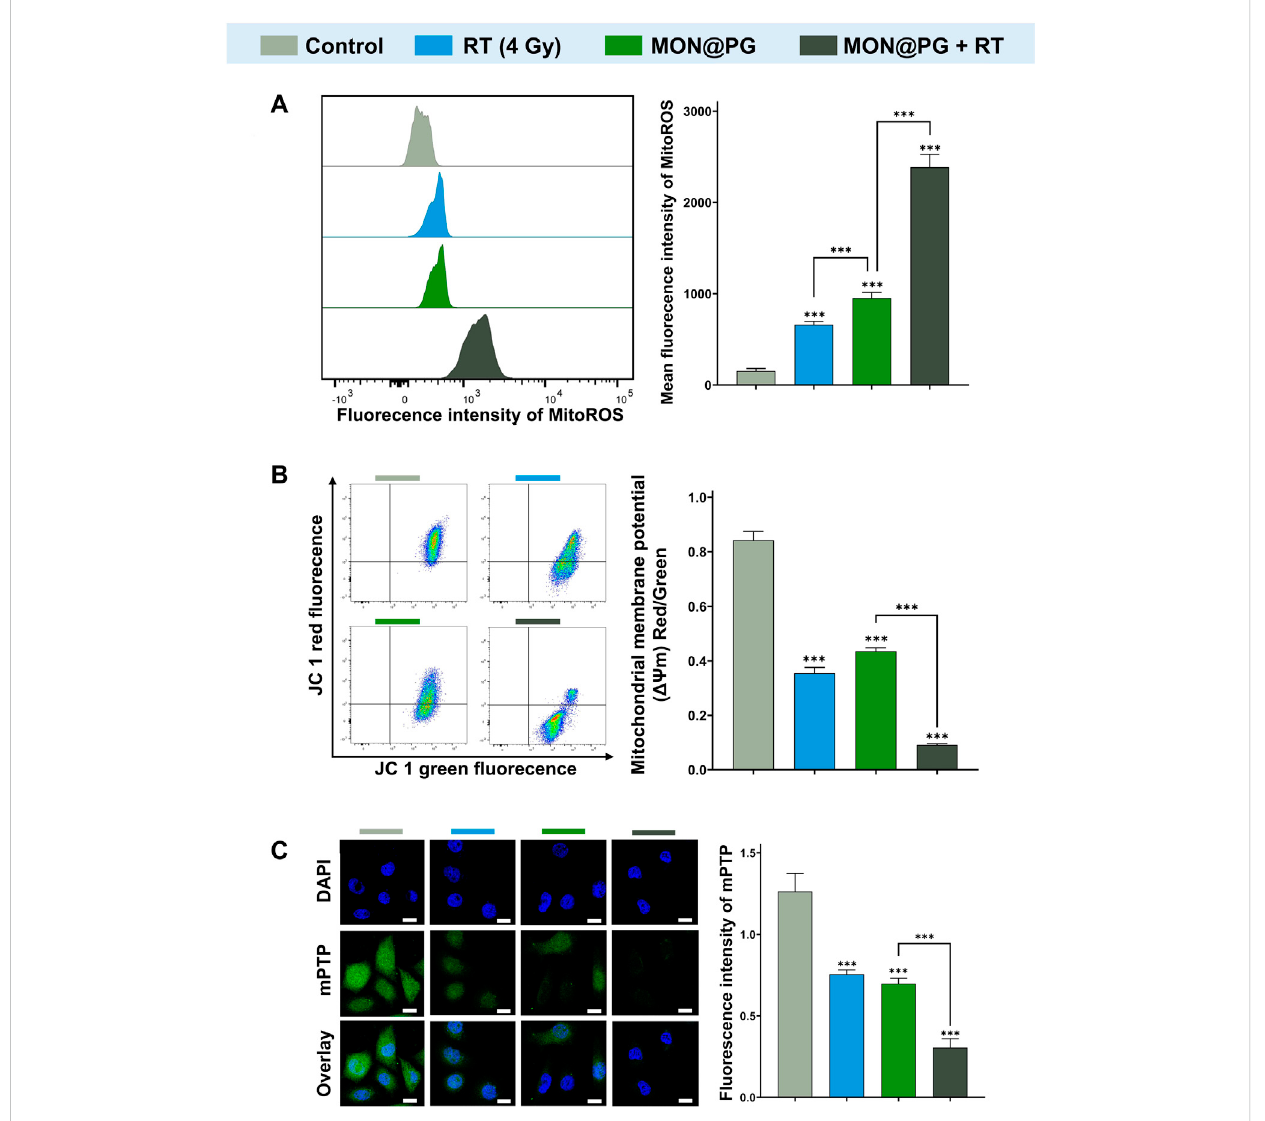
FIGURE 4 Mitochondrial dysfunction induced by MON@PG combined with irradiation. (A) MitoROS level of different treatment groups: fl ow cytometry imaging (left) and associated analysis (right). (B) Flow cytometry of JC-1 fl uorescence (left) and associated statistical analysis (right) of different treatment groups. (C) Representative mPTP CLSM fl uorescence images of treated GC cells (left) and associated statistical analysis (right). Scale bars: 10 μ m. Outcomes are displayed as mean ± SD (n = 3, *** p <